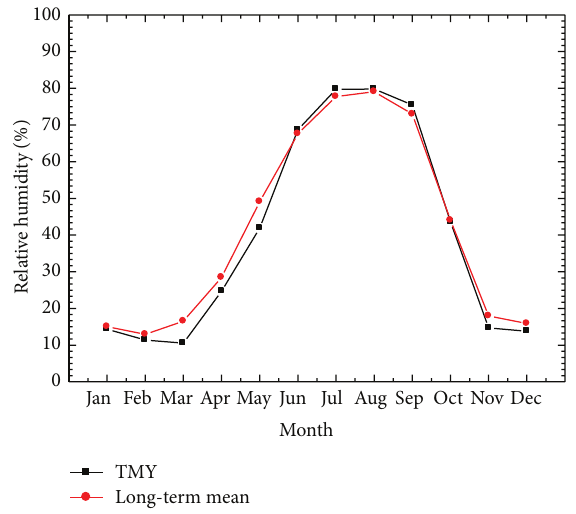
Figure 4: Predicted TMY with long-term average values for the relative